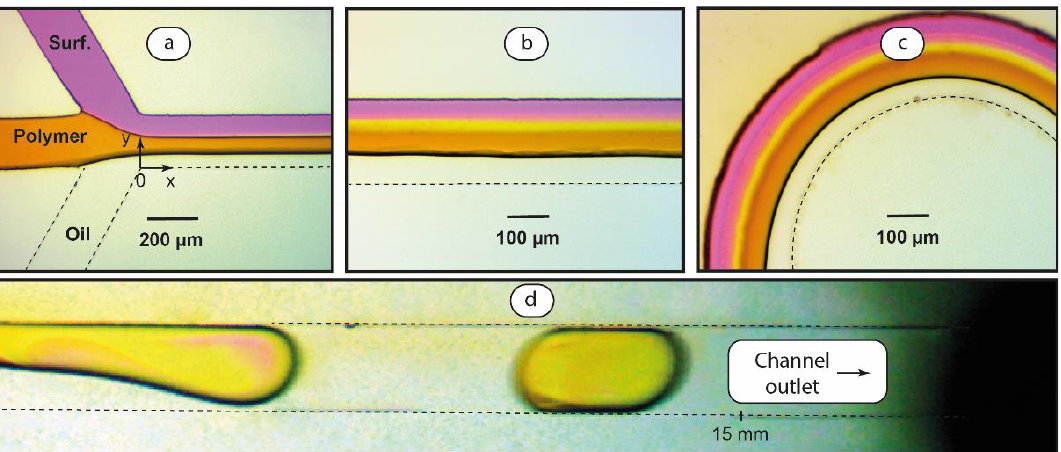
Figure 7. Optical microscopy images of SDS, PDADMAC, and hexadecane flows: linear thread formation ( a ), stable thread in the serpentine channel ( b ) and linear channel ( c ), and thread break-up and mixing of reagents ( d ) near the main channel outlet. Ca ≈ 0.05, φ = 3. Dyes (phenolphthalein + 0.01 M KOH and iodine) were added to surfactant and polymer solutions, respectively, for visualization. Dashed lines mark microchannel boundaries.